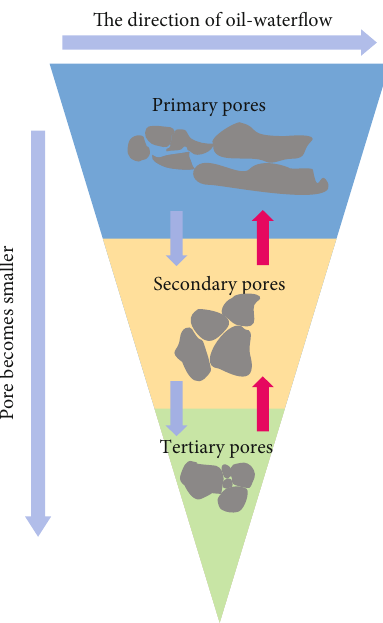
Figure 11: Conceptual model of multistage seepage in tight reservoir.